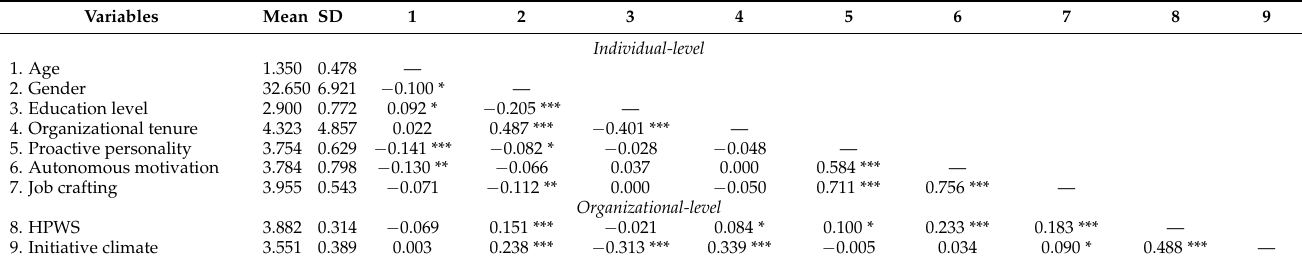
Table 2. Descriptive statistics and correlations among study